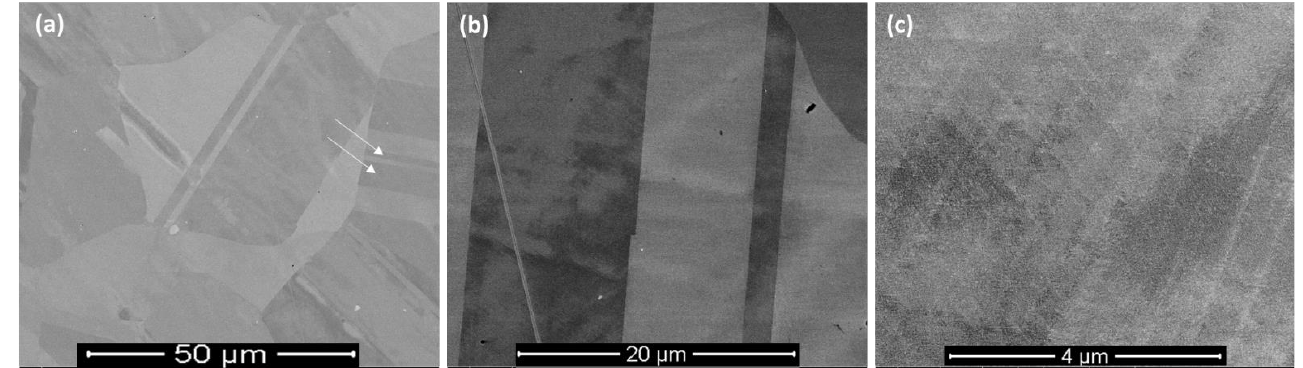
Figure 3. SEM micrographs of cast Inconel 718 after metallographic polishing at different magnification: ( a ) ×500, ( b ) ×2000 and ( c ) ×10,000. The white arrows indicate the location of the twins.